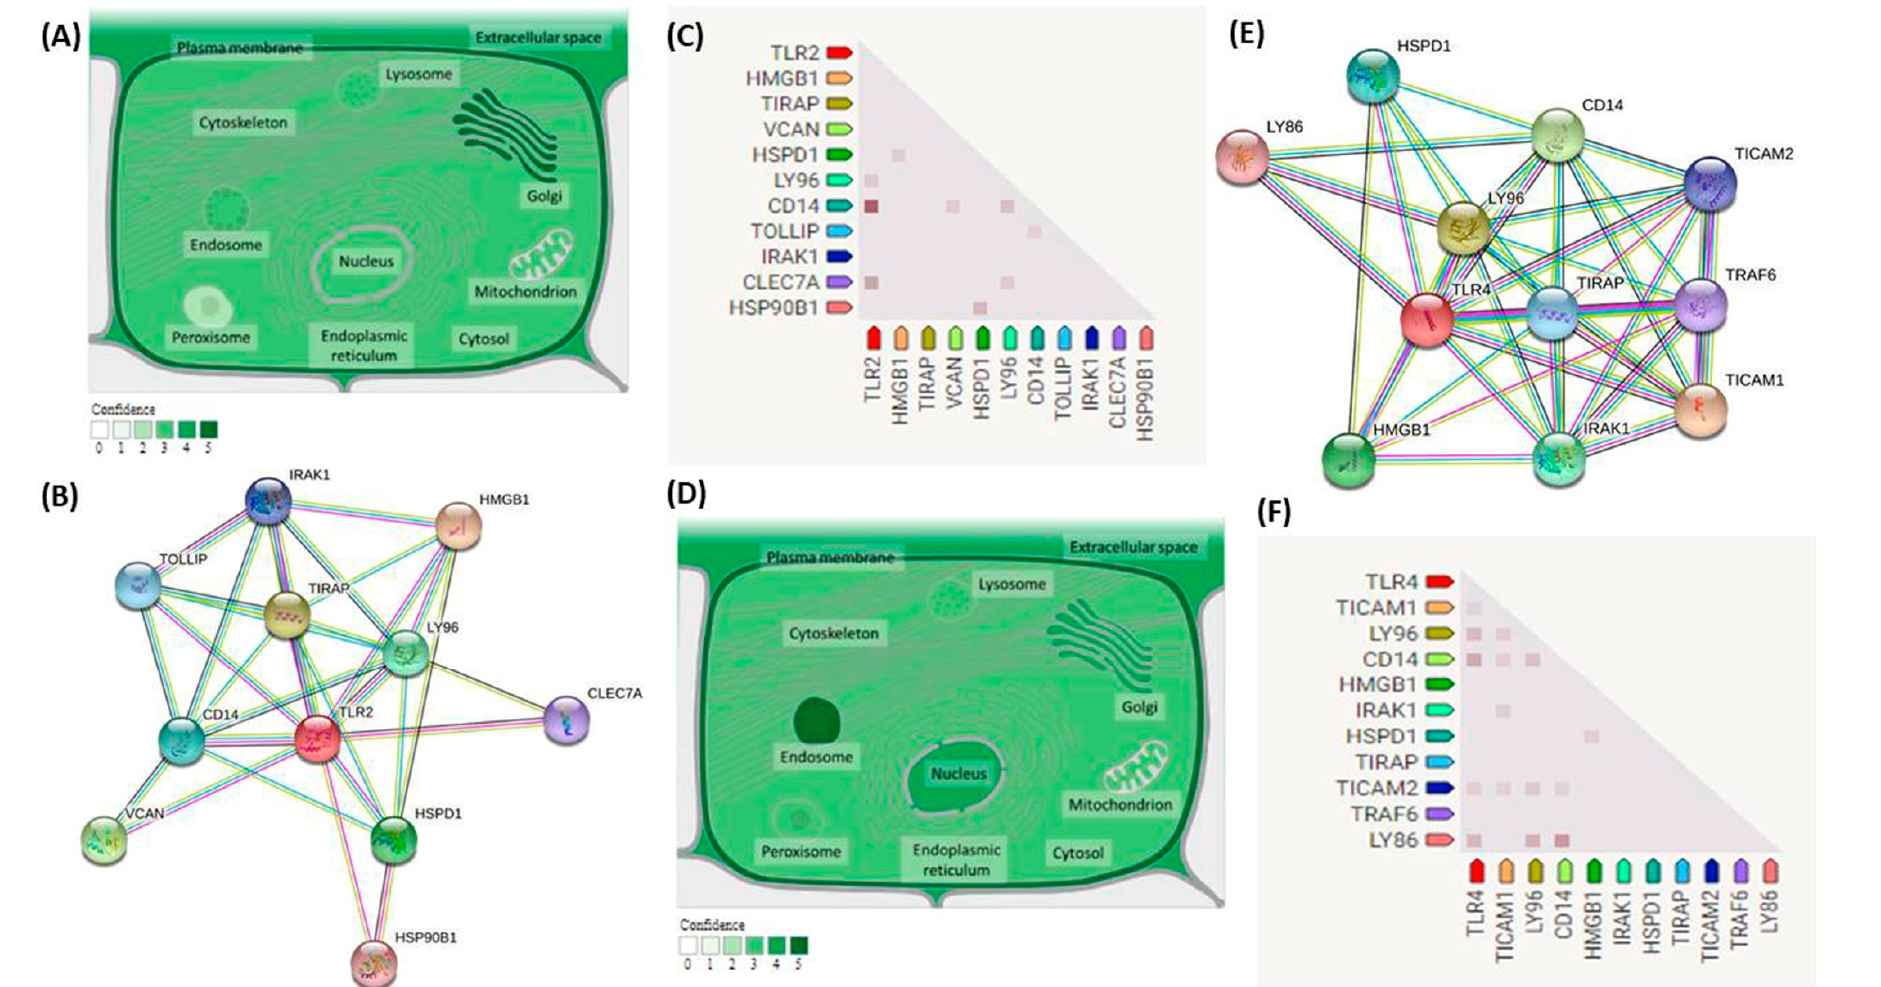
Figure 2. Functional Analysis of TLR2 and TLR4 proteins. ( A ) Subcellular localization of the TLR2 protein. The gradient of green color indicates the degree of confidence (genecards.org) with (compartments.jensenlab.org) as the source of the image. ( B ) Predicted network of protein–protein interactions of the TLR2